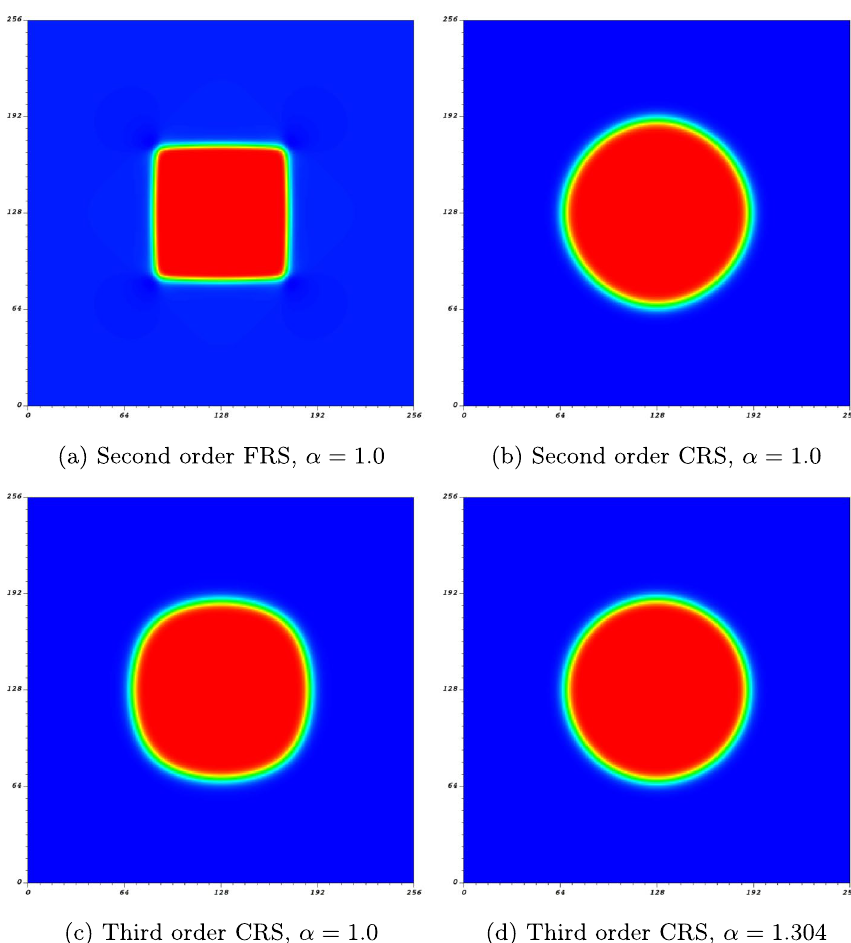
Fig. 5 Density contours produced by DUGKS employing different reconstruction schemes, τ = 0.3 , T r = 0.95